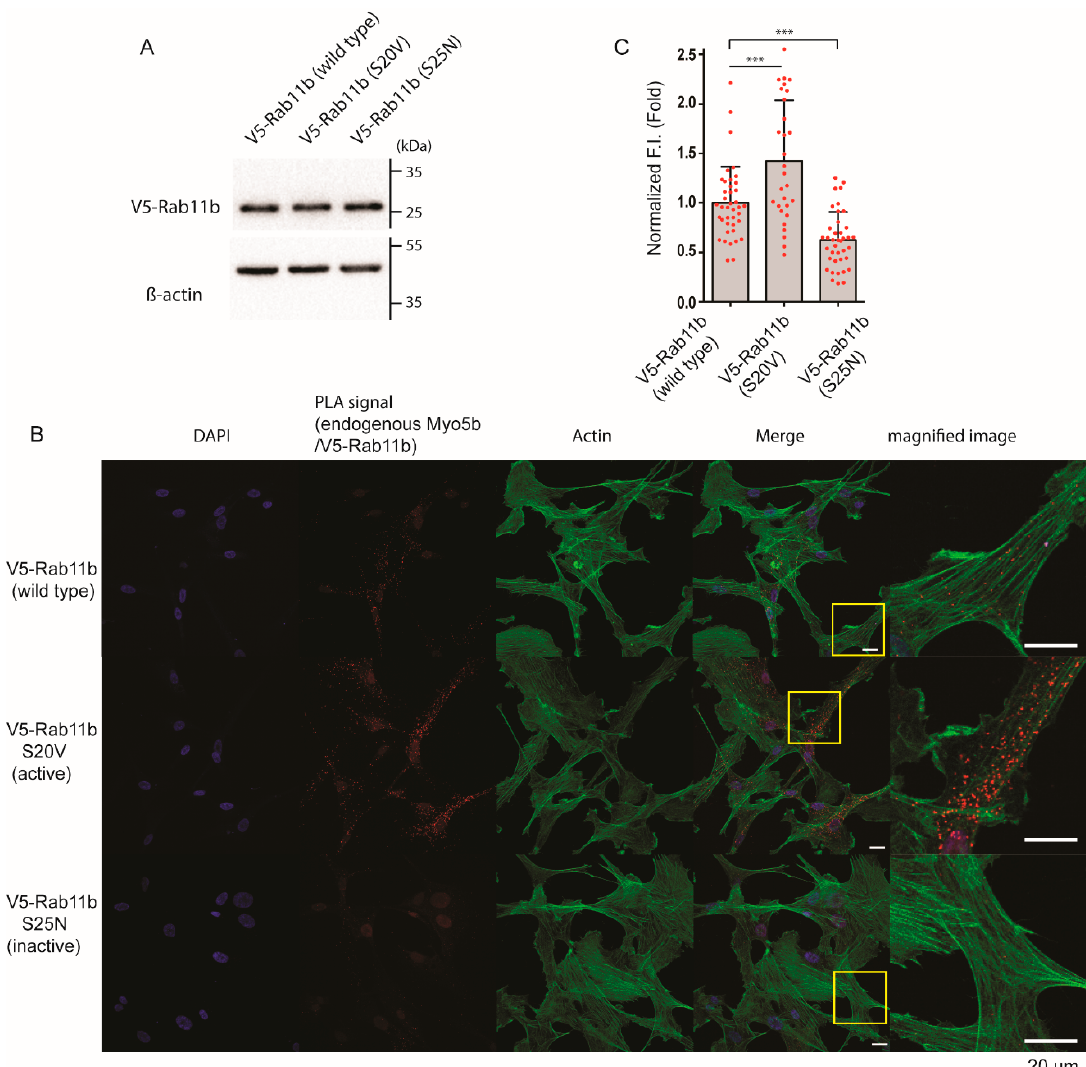
Figure 10. Effect of Rab11b activation on close association between Myo5b and Rab11b revealed by Proximity ligation assay. ( A ) Western blot of HPMCs expressing v5-Rab11b, v5-Rab11b-S20V and v5-Rab11b-S25N, respectively. V5-Rab11b variants were expressed in HPMCs at comparable levels. Full-length blots were presented in Supplementary Figure S4. ( B ) Confocal images of proximity ligation assay of Myo5b and Rab11b variants in HPMCs. V5-Rab11b variants were expressed in HPMCs and proximity ligation assay was performed. Proximity ligation signals were shown in red. Scale bars; 20 μ m. ( C ) Statistical representation of the proximity ligation signal intensities between endogenous Myo5b and each V5-Rab11 variants (mean ± SD). *** p < 0.001. The red spots in bar graphs display the distribution of data points.